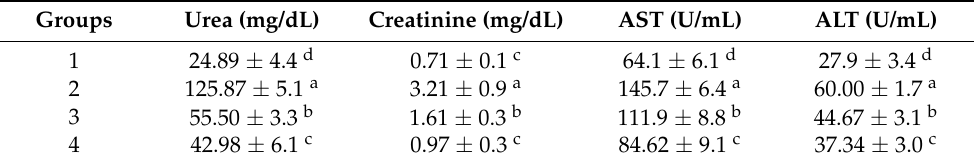
Table 3. Liver and kidney function in lead-acetate-induced anemic rats treated with chemical or green biosynthesized magnetic iron oxide